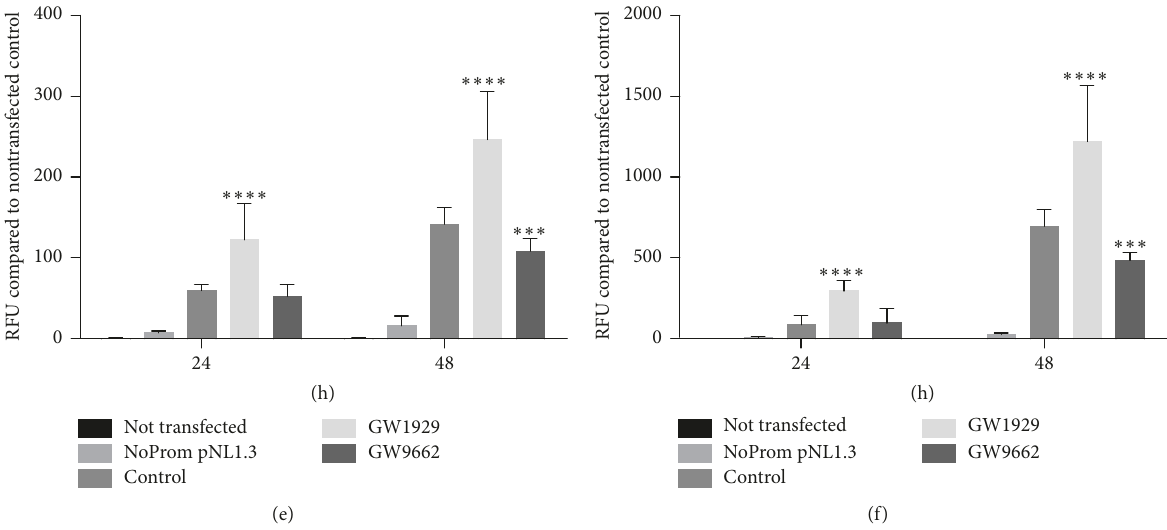
Figure 2: PPRE-H2B-eGFP and PPRE-pNL1.3[secNluc] transfections of VCT: new models to visualize and quantify the activity of PPAR 𝛾 . (a) Merged staining of PPRE-H2B-eGFP (green), cell shape using F-actin (red), and nuclei using DAPI (blue) in 48h treated VCT with 1 𝜇 M GW1929 (agonist of PPAR 𝛾 ) or 1 𝜇 M GW9662 (PPAR 𝛾 antagonist) compared to control (vehicle). 3D nuclei segmentation (b) and quantification (c) of PPRE-H2B-eGFP fluorescence intensity using Icy software. (d) PPRE-H2B-eGFP protein levels were assessed using western blotting. (e-f) Spectrophotometry reading of luciferase expression for 50 𝜇 l (e) or 100 𝜇 l (f) of supernatant from 24- and 48-hour PPRE-pNL1.3transfectedand1 𝜇 MGW1929or1 𝜇 MGW9662treatedVCTcomparedtonontransfectedcells(control).Valuesarerepresented as mean ± SD; ∗∗∗ 𝑝 < 0.001, ∗∗∗∗ 𝑝 < 0.0001 versus vehicle control ( 𝑛 = 3